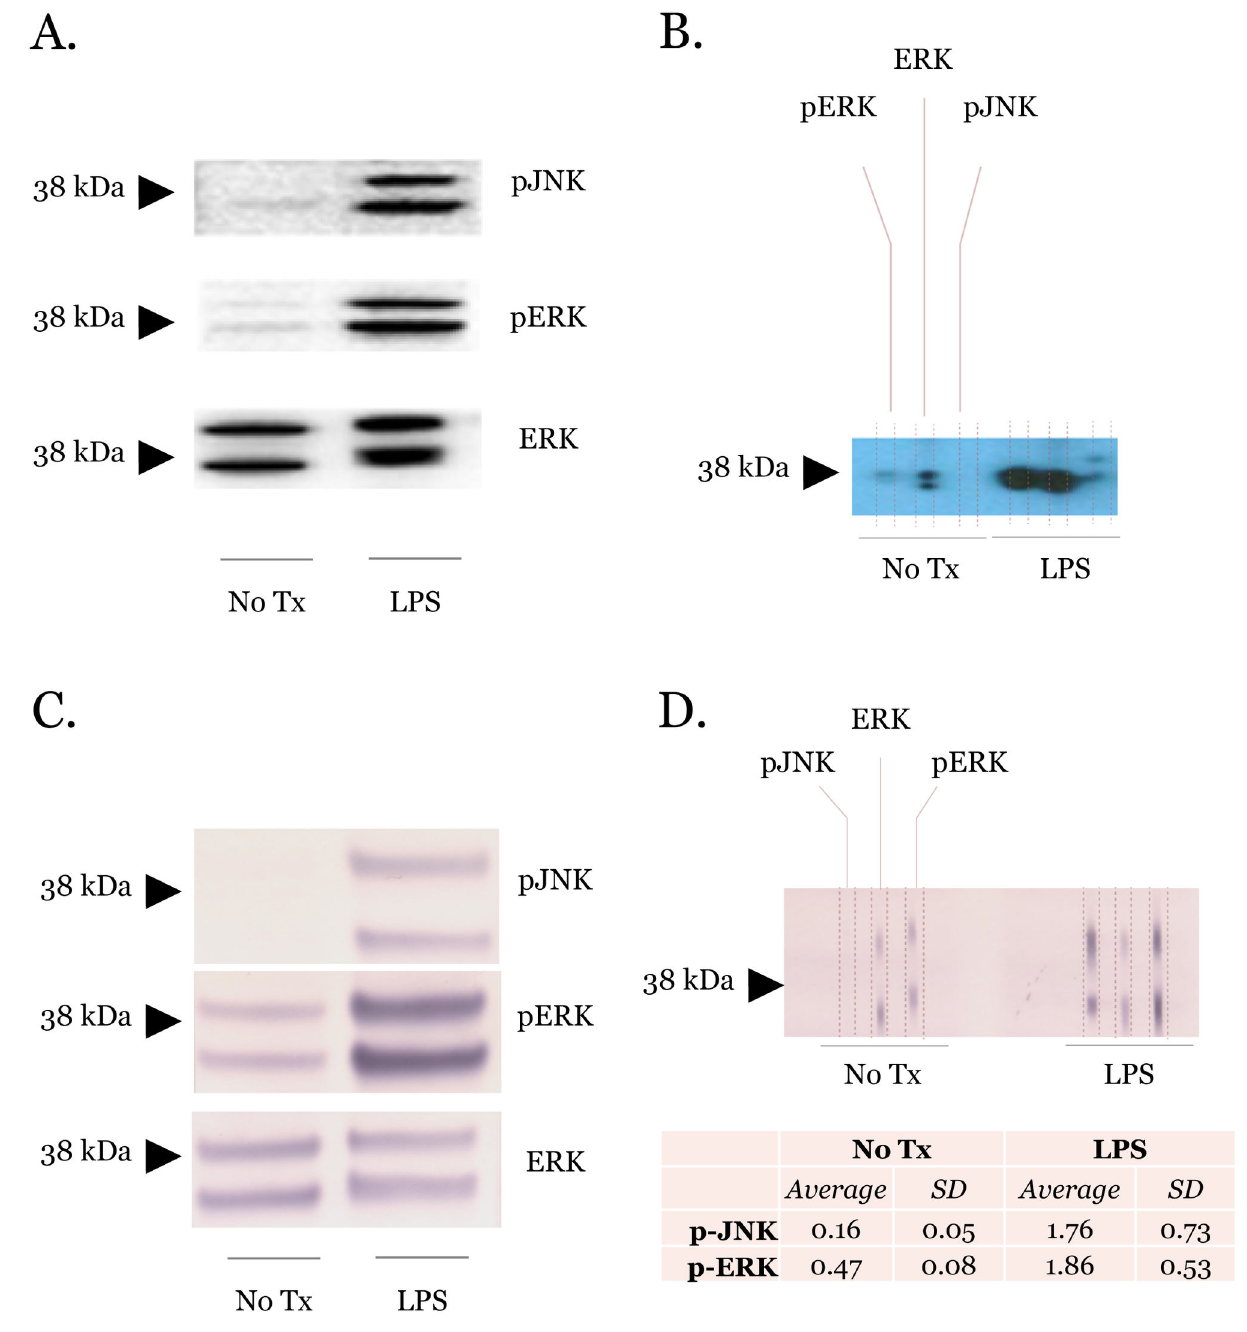
Figure 4. Protein immunoblots of the MAPK pathway using different chemiluminescent detection modalities. (A) Traditional immunoblots of RAW264.7 cell lysates with or without LPS for 45 minutes. Membranes were probed for phospho-JNK and phospho-ERK using total ERK as the loading control. Primary antibodies were detected using HRP chemiluminescent techniques. (B) Microfluidic immunoblots mirroring conditions in (A). (C) and (D) are identical to (A) and (B) except they were performed using AP chemiluminescent secondary antibodies to detect primary antibodies. The signal intensities from three microfluidic immunoblots were quantified using ImageJ. Immunoblots are representative of at least three independent PVDF membranes.